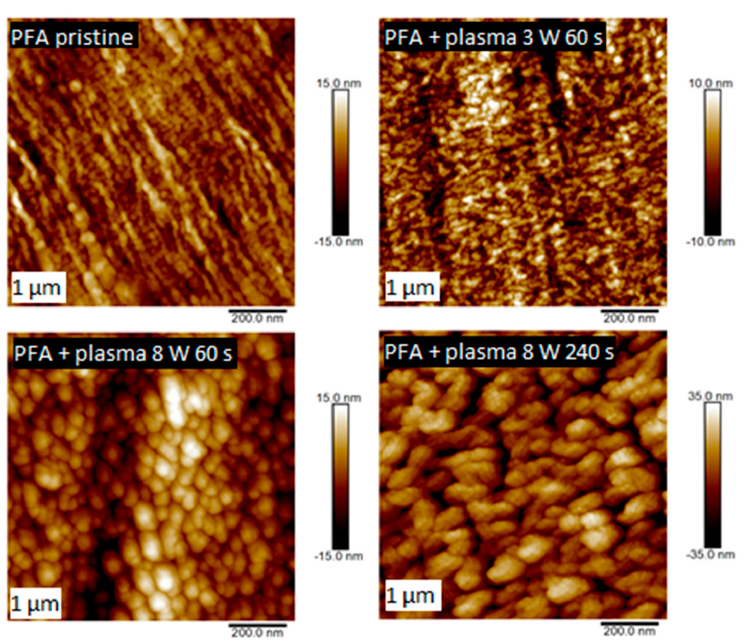
Figure 6. Surface morphology studied by AFM for pristine PFA and PFA treated by plasma at 3 W for 60 s and 8 W for 60 and 240 s. On the pristine PFA sample (a square of 1 × 1 µm 2 ), globular structures are visible, the original fibrous structure was also partially preserved. Plasma modification led to an increase in the number of such nanostructures, an increase in surface roughness and sur- face fragmentation, as shown in Figure 7. This Figure 7 shows the surface roughness for the untreated PFA and for PFA subjected to plasma treatment at 3 and 8 W for 60, 120, and 240 s. As expected, the PFA surface roughness increased with increasing power and exposure time. A small decrease in PFA surface roughness was detected on the sample modified with the plasma of 3 W for 60 s. This phenomenon is probably caused by the low plasma power and the possibility of partial “smoothing” of the sample in the initial phase of plasma modification. The highest roughness on the PFA surface was detected on a sam- ple treated for the longest exposure time at 8 W power; the roughness was almost three times higher than on the untreated PFA sample.